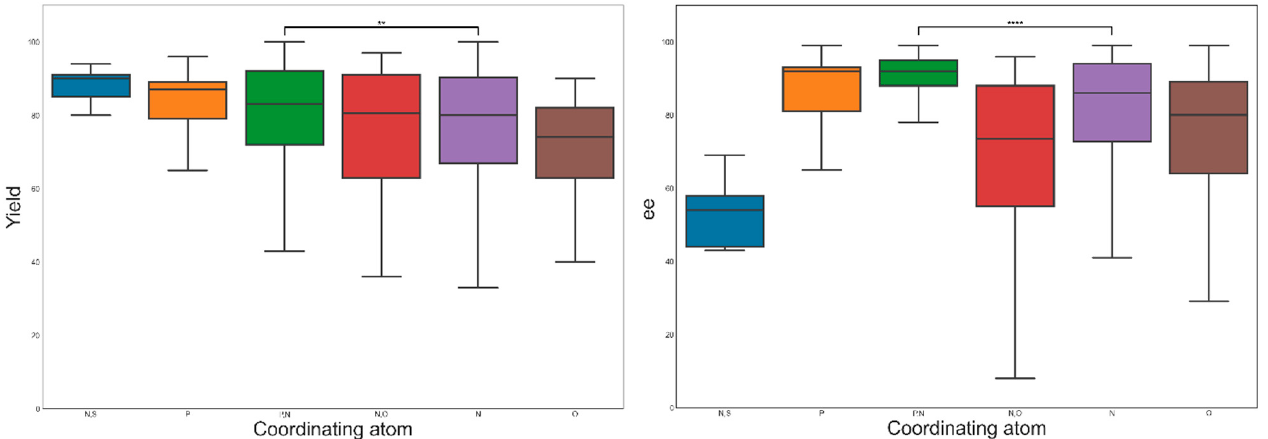
Figure 10. ( left ) Yield of enantioselective A 3 reactions ( ee > 0). Statistical analysis performed using Student’s t -test ( p = 0.0098) ( right ) ee of enantioselective A 3 reactions ( ee > 0). Statistical analysis performed using Student’s t -test ( p = 1.56 × 10 − 10 ). Symbol Meaning: ** p ≤ 0.01, **** p ≤ 0.0001 (For the last two choices only).